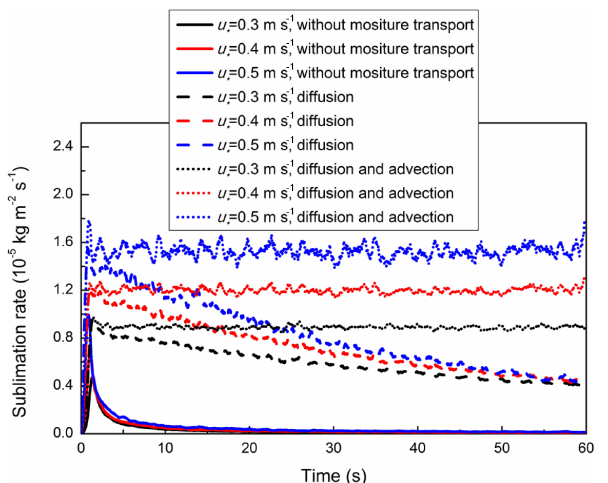
Figure 3. Temporal evolution of drifting snow sublimation rate for three wind force levels neglecting moisture transport, considering only moisture diffusion and both moisture diffusion and advection.